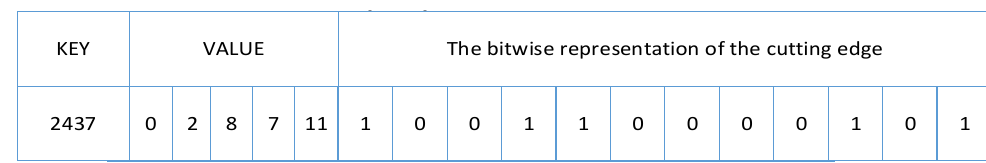
Figure 6. Schematic of the cutting